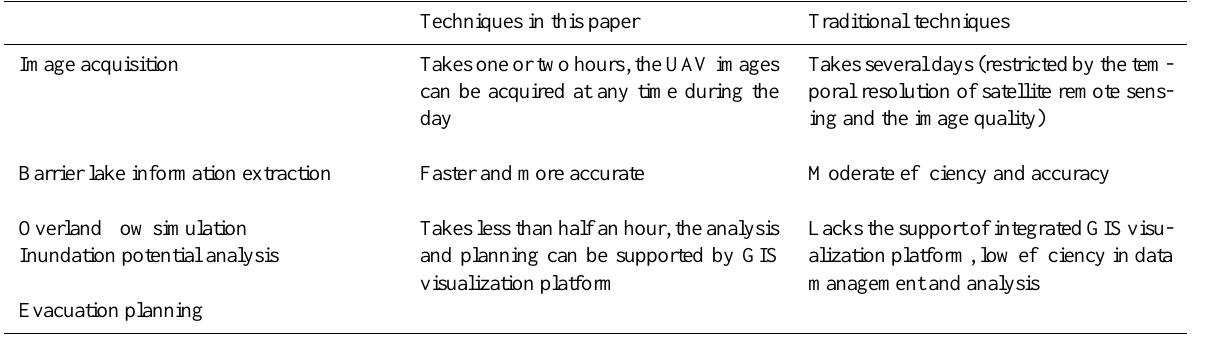
Techniques in this paper Traditional techniques Takes several days (restricted by the tem- can be acquired at any time during the poral resolution of satellite remote sens- day ing and the image quality) Takes less than half an hour, the analysis Lacks the support of integrated GIS visu- and planning can be supported by GIS alization platform, low efficiency in visualization platform